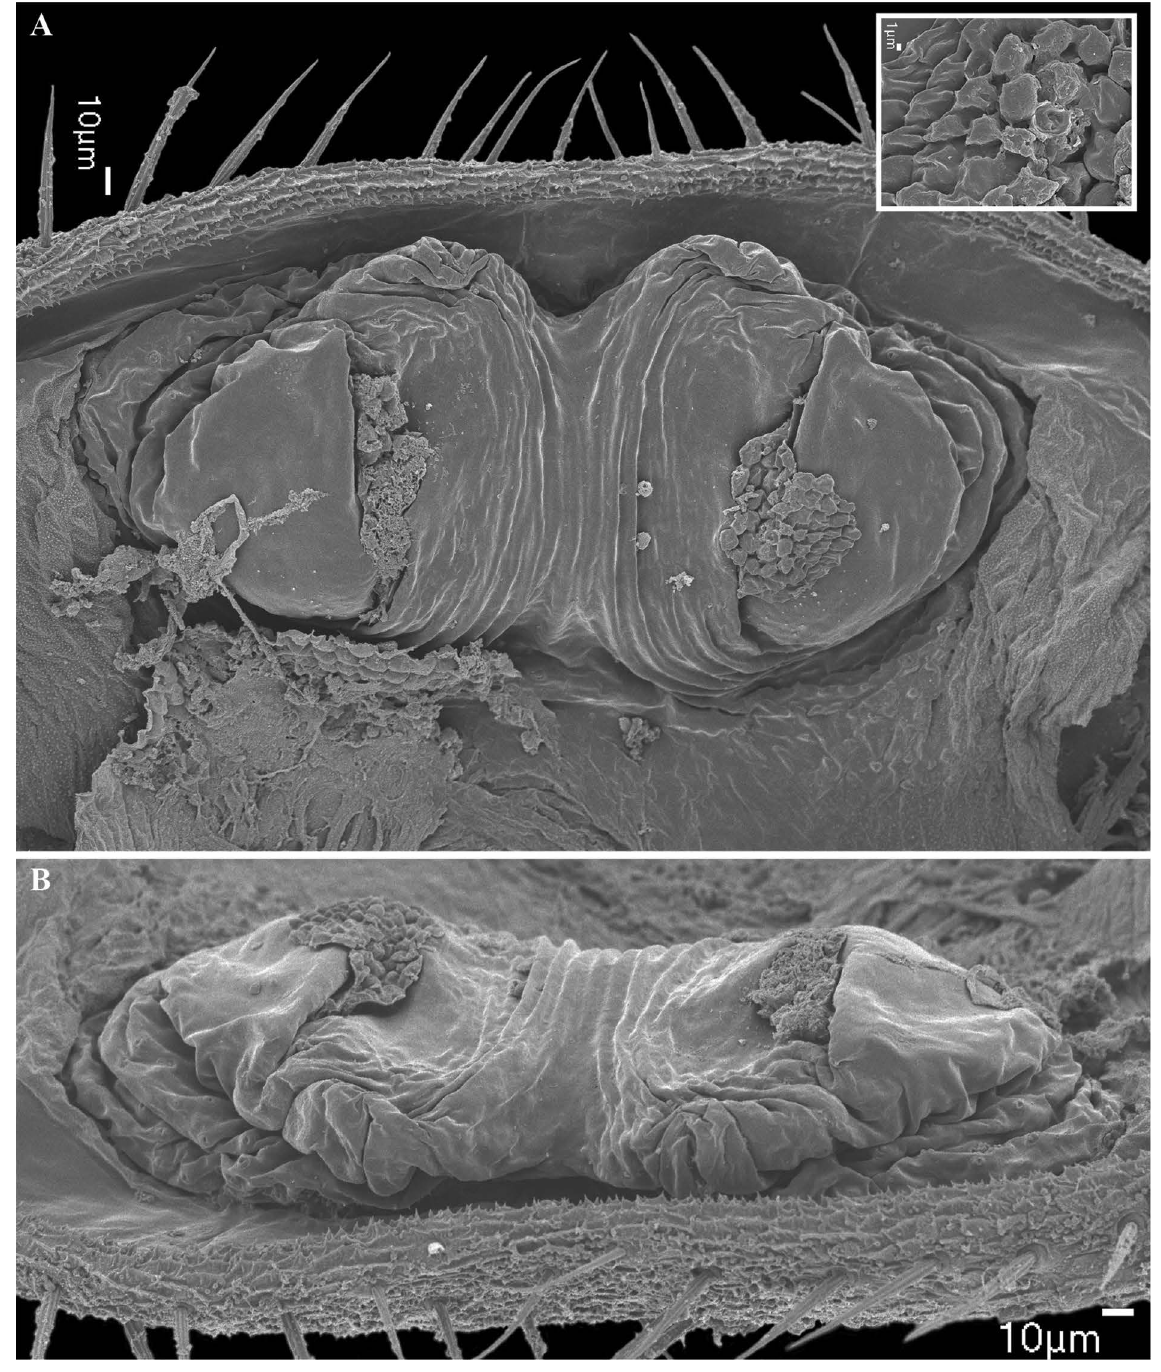
Fig. 22. Charinus dominicanus Armas & Perez, 2001 (AMNH), female gonopod. A . Dorsal view. Inset: sperm sac attached to atrium entrance. B . Posterior